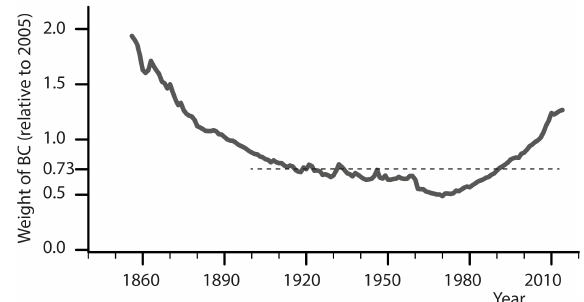
Figure 10. Relative weight of black carbon emissions versus equiv- alent SO 2 emissions as compared to a value of unity in 2005. For example, a value of 0.75 in 1920 implies that the emissions of black carbon relative to the weighted SO 2 and NH 3 emissions were 75% of their 2005 value. The dashed line, corresponding to a ratio of 0.73, is the mean from 1900 to the present.